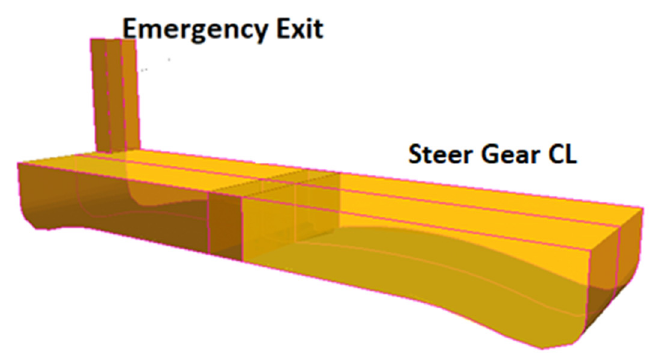
Figure 4. The steering gear compartment of the EMSA2-RoPax.